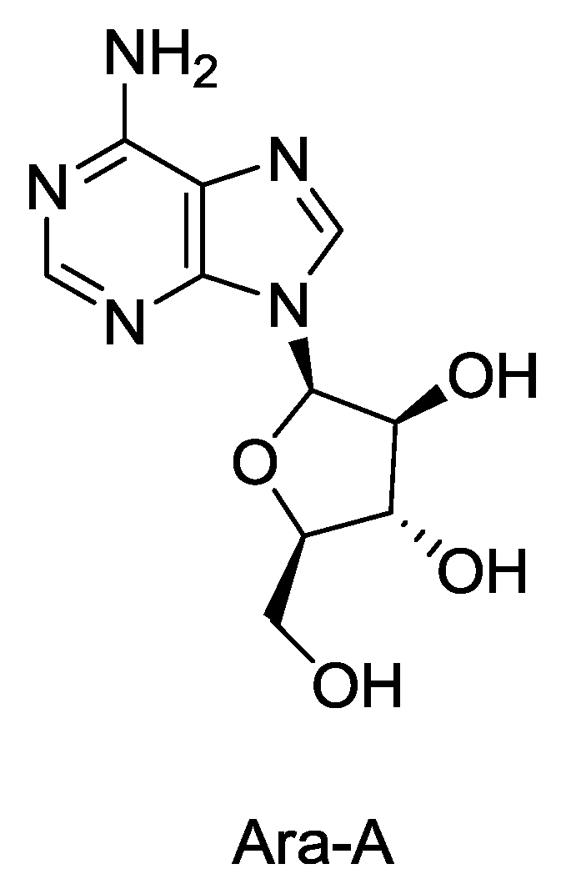
Structure of Ara-A.